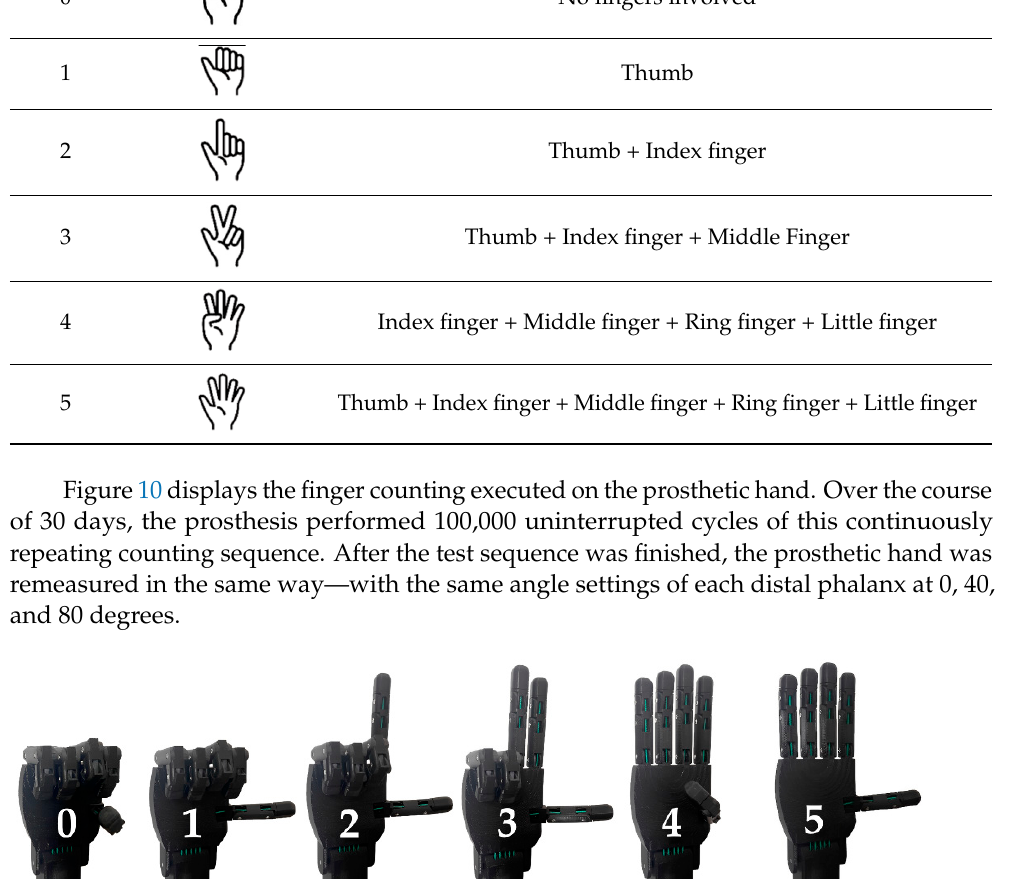
Table 1. Western world finger-counting system.